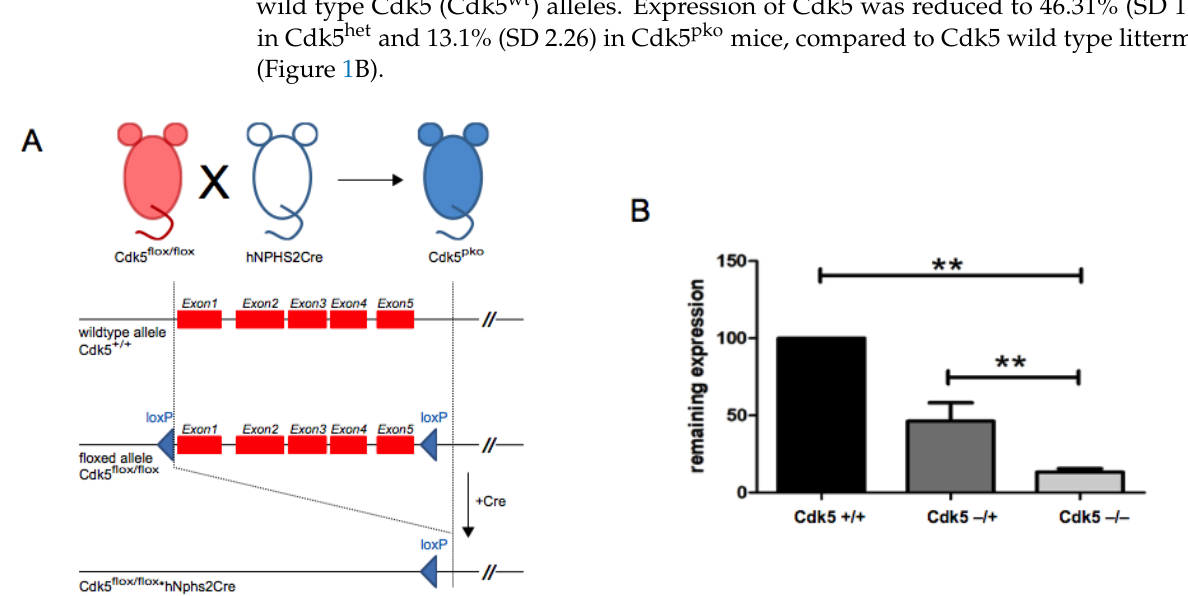
Figure 1. Breeding scheme and validation of podocyte-specific Cdk5 knockout. ( A ) Cdk5flox/flox mouse mated to the hNPHS2.Cre mouse yields podocyte-specific deletion of the Cdk5 gene (Cdk5 pko ). ( B ) Remaining expression of Cdk5 was quantified by qPCR from primary isolated podocytes. Cdk5 expression relative to wild type (Cdk5wt) is indicated. In podocyte-specific Cdk5flox-heterozygous mice (Cdk5 het ), Cdk5 expression was reduced to 46.31% (SD 11.86). For podocyte-specific knockout of Cdk5 (Cdk5 pko ), the remaining expression of Cdk5 was 13.1% (SD 2.26). ** p -value < 0 . 01, In each cohort, n = 3.